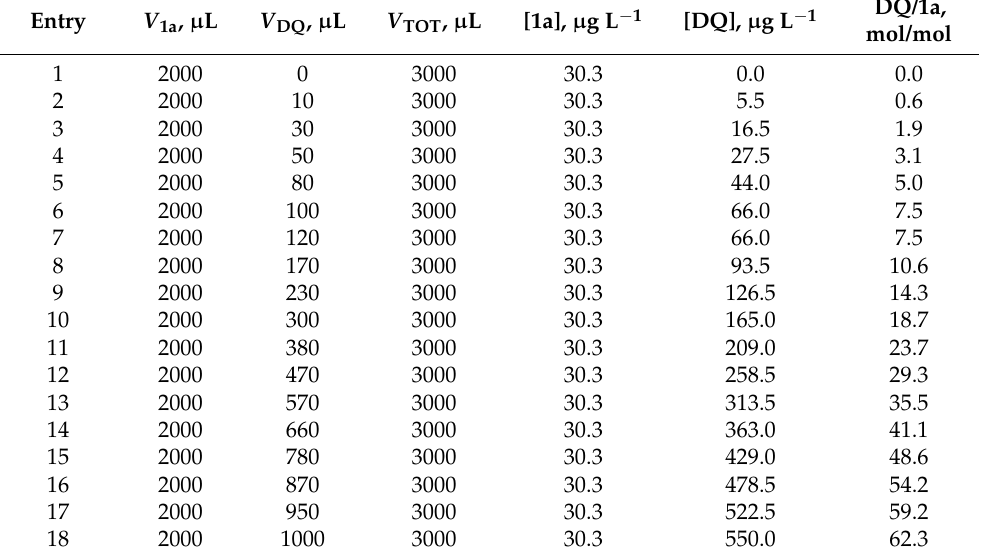
Table 3. Experimental data for the determination of spectra reported in Figure 5. The V 1a and V DQ volumes refer to an initial 1a solution with a concentration of 45.5 µ g L − 1 and diquat, DQ, solution with a concentration of 1650 µ g L − 1 , respectively. The final volume of each solution was made up to a total volume of 3000 µ L by fixing with the solvent